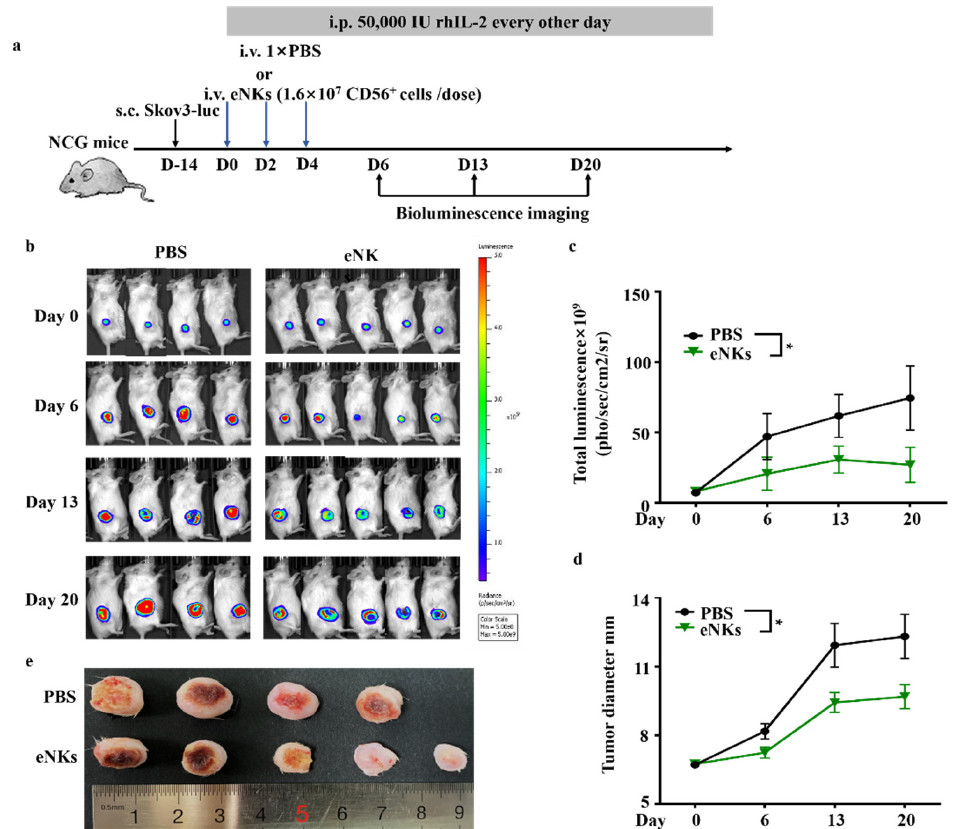
Figure 4. eNKs inhibited tumor growth in a Skov3 xenograft solid tumor model of human OC. ( a ) Schematic timeline of eNK treatment and establishment of a human OC solid tumor model by subcutaneous injection with Skov3-luc cells in NCG mice. ( b ) Animal bioluminescence imaging of the tumor burden following adoptive transfer of eNKs at the indicated times. ( c ) Summary of bioluminescence measurements in different treatment groups over the 20-day experimental period. Significance was determined by two-tailed paired Student t -test. ( d ) Tumor diameters were measured for each treatment group. Significance differences were determined by two-tailed paired Student t -test. ( e ) The images of tumors obtained from the eNK- and PBS-treated (control) groups at the 20th day after the initial eNK infusion. Results are representative of two or three independent experiments. Data are represented as means ± SD. * p < 0.05.